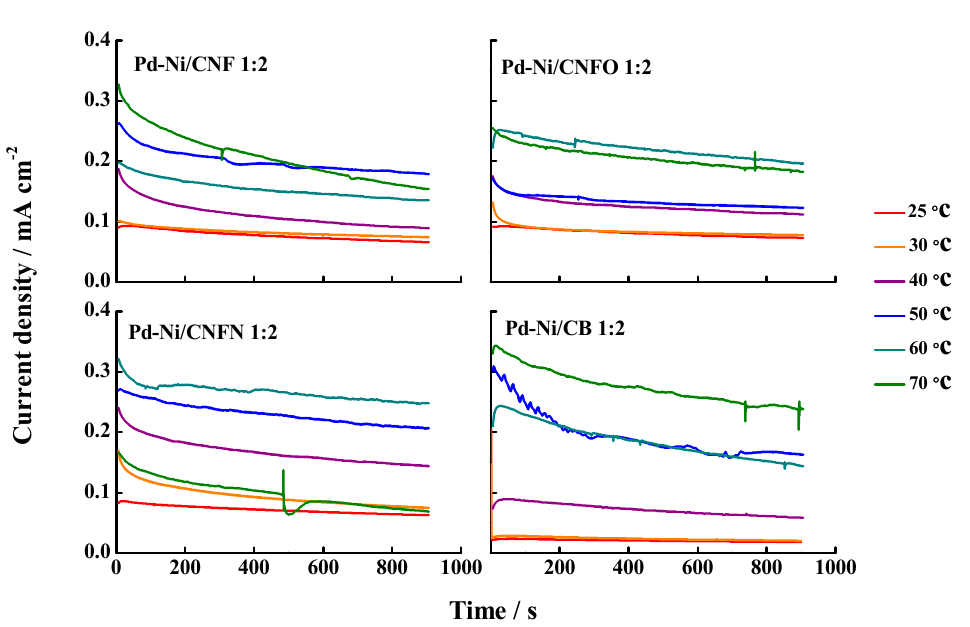
Figure 10. Selected current transients for the synthesized Pd ‐ Ni catalysts at the temperature range (20–70 ° C). Support electrolyte: 0.1 M KOH. Scan rate: 20 mV ∙ s − 1 . Methanol concentration: 1.0 M. Applied potential: 0.6 V vs. RHE.